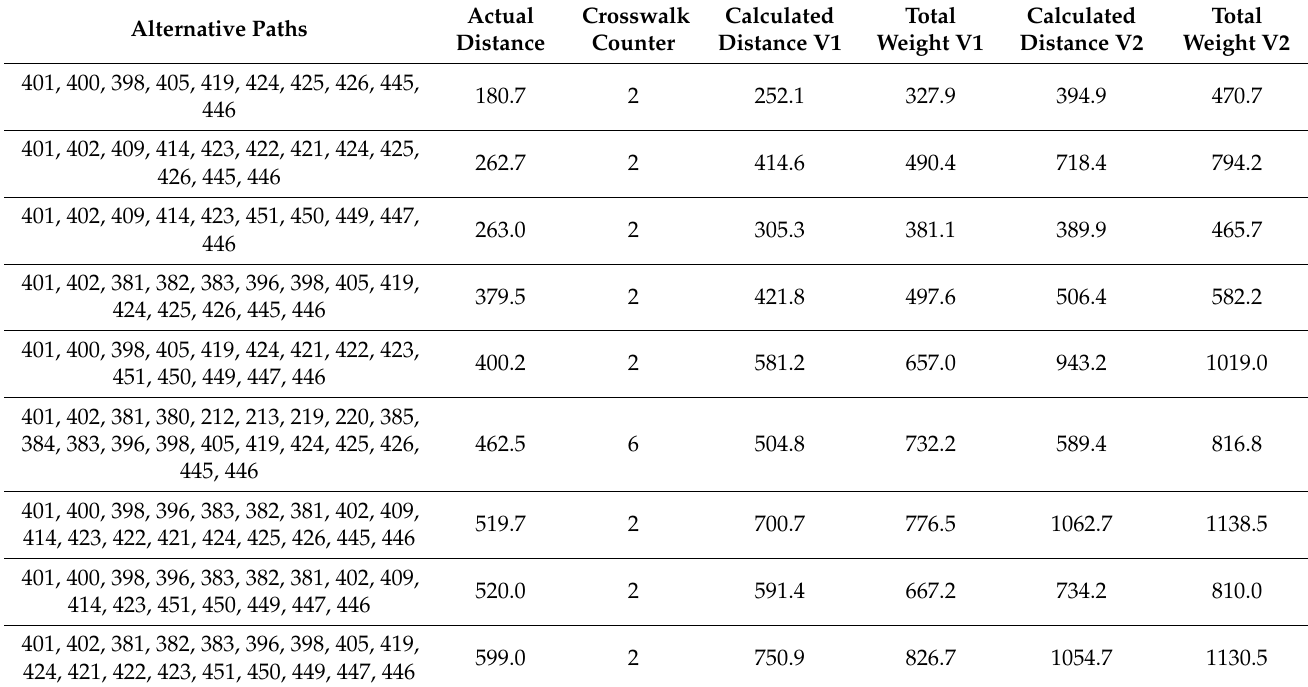
Table 3. k-shortest paths for use case